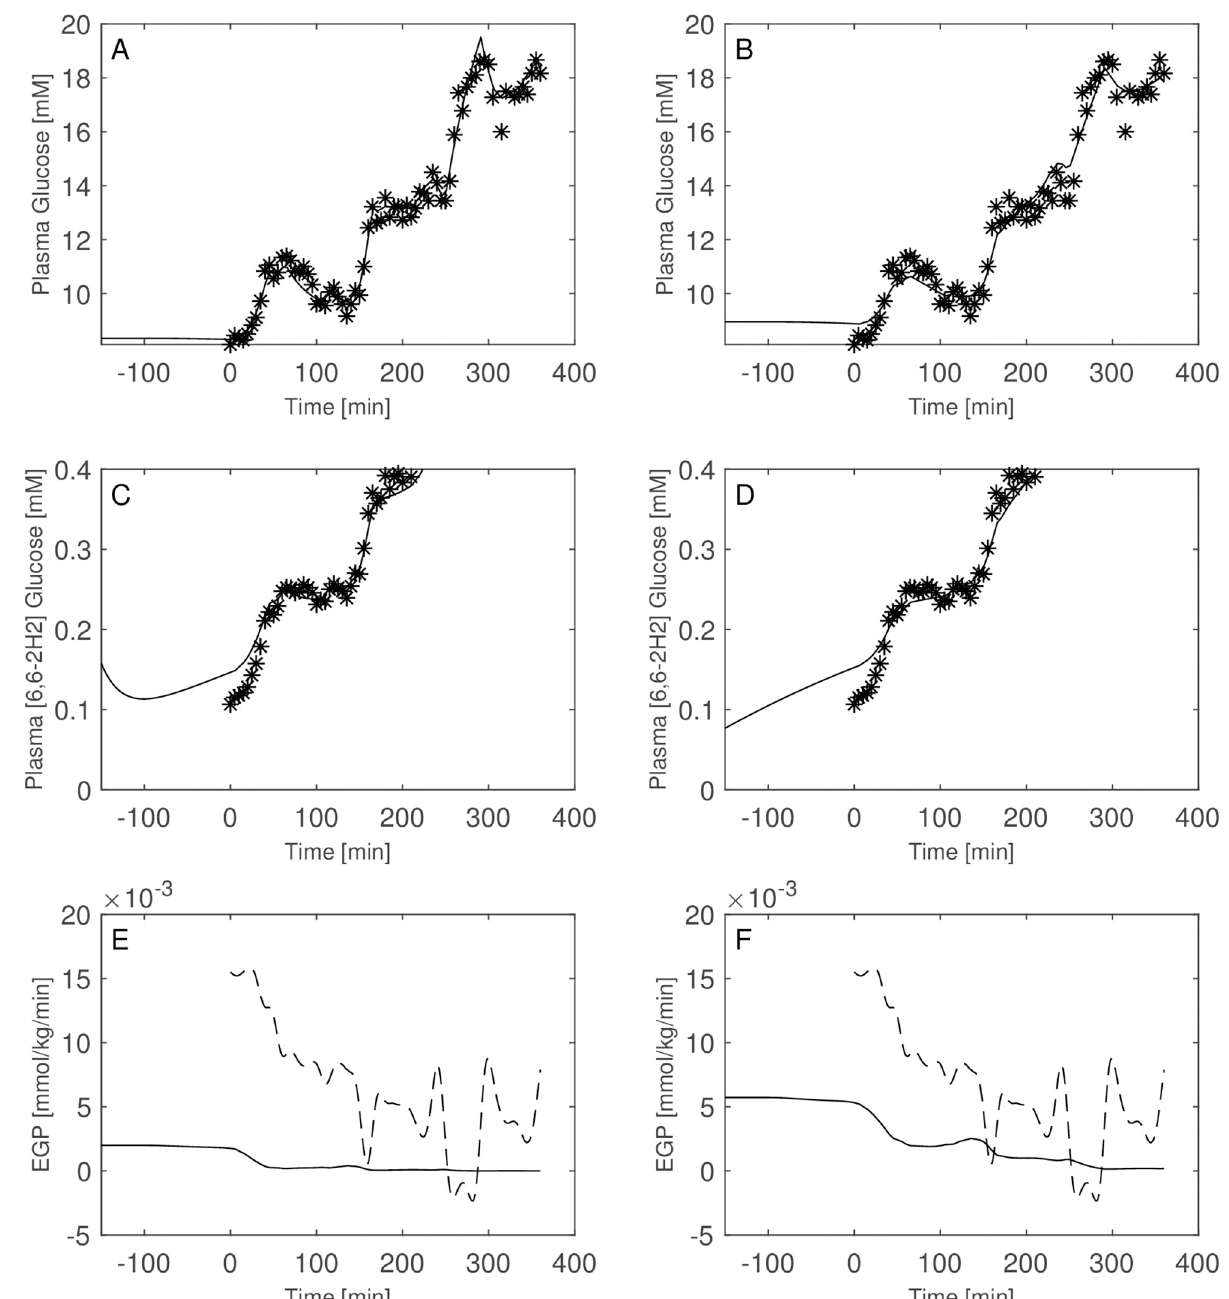
Fig 13. Model comparison for Subject 5. Observed (asterisks) and predicted (line) variables over time with glucose two-compartment model (Panels A, C, E) and one-compartments-glucose model (Panels B, D, F). Dashed line is the predicted EGP with the Steele model. All the observed points refer to data measured on day 2. Plasma glucose concentrations (panel A) are derived from the glucose intra-venous infusion to match plasma glucose observations from the OGTTs of day 1.